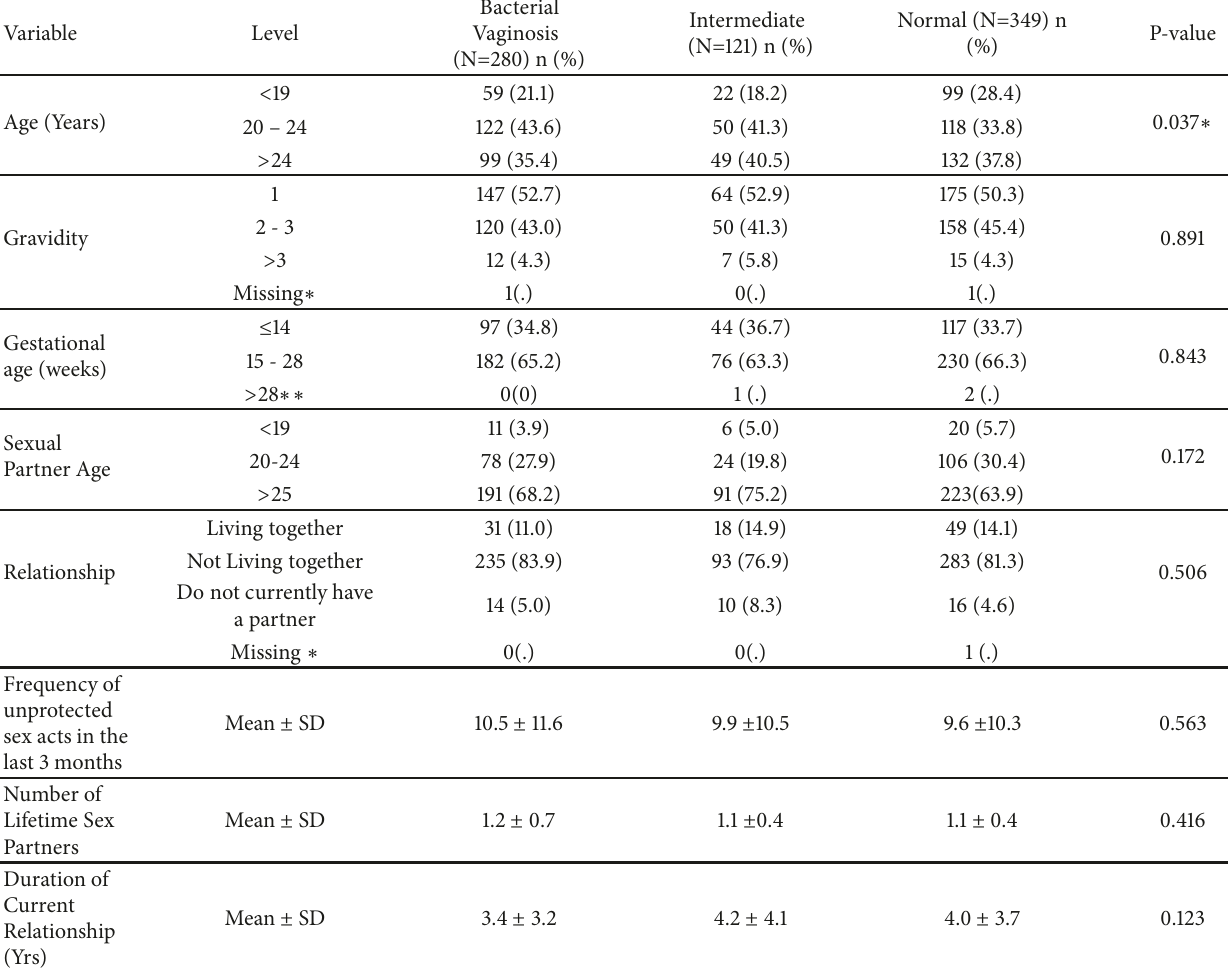
Table 2: Demographic and behavioural correlates of bacterial vaginosis in HIV negative pregnant